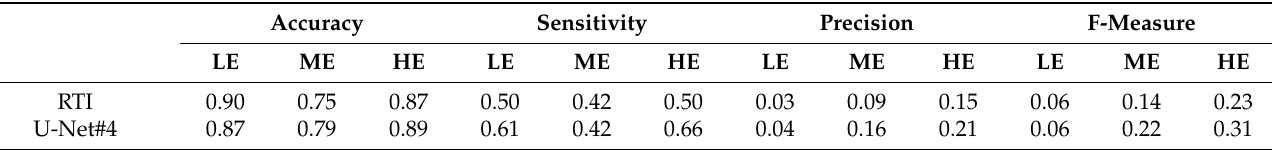
Table 6. Performance evaluation of RTI and U-Net #4 model using 36 PlanetScope images. FOMs were evaluated according to the red tide extent.